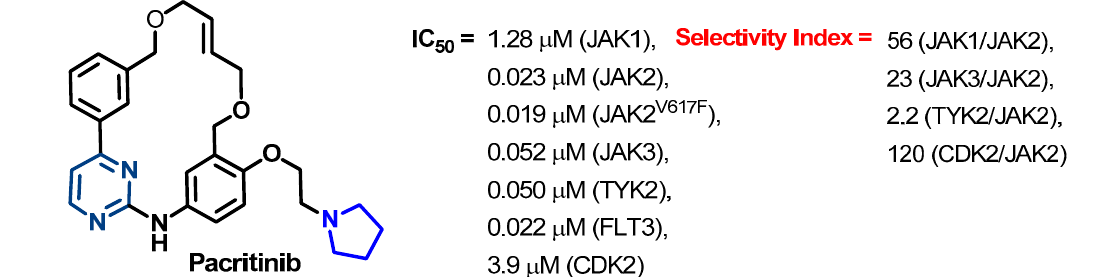
Figure 41. Binding modes of pacritinib (shown as sticks) into human quinone reductase 2 (NQO2) (pdb: 5LBZ): ( A ) 3D binding mode, receptor shown as a hydrogen bond surface; ( B ) 2D binding mode showing different types of binding interactions; this figure was generated using Discovery Studio Visualizer (V16.1.0.15350). Pharmacological Activities and Uses Pacritinib acts as an inhibitor of both JAK2 and FLT3 that could be used to overcome the resistance problems in patients with acute myeloid leukaemia (AML) [30]. The dual activity against the two kinases could enable pacritinib to overcome the resistance medi- ated by the upregulation of JAK2 in FLT3-TKI-resistant AML cells [30].